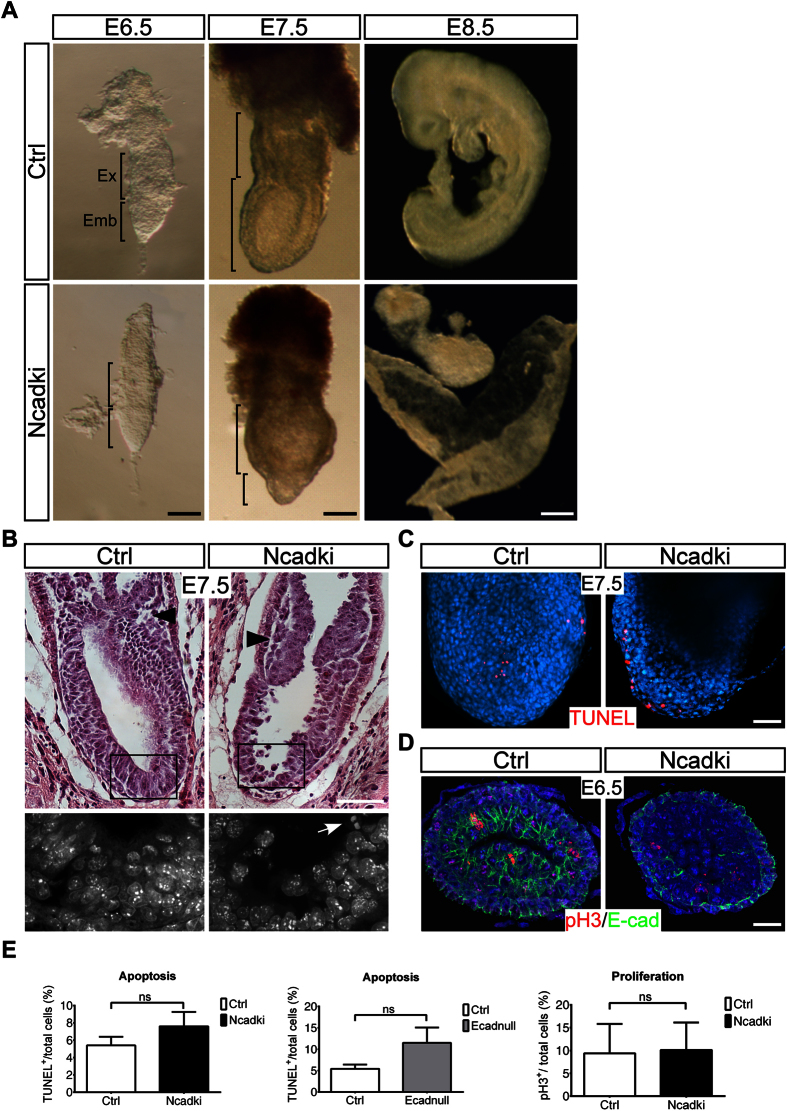
Ectopic switching from E-cad to N-cad expression in the epiblast before gastrulation results in degeneration of the epiblast at E7.5 and embryos are incapable to survive beyond E8.5.(A) Bright field images of EcadNcad/ΔEpi (Ncadki) mutant and EcadNcad/fl and Ecad+/ΔEpi control (Ctrl) embryos at stages between E6.5 and E8.5, showing size reduction of the epiblast in mutant embryos at E7.5. Scale bars represent 100 μm for left and middle and 250 μm for right panel. (B) Histological analysis of sagittal sections at E7.5. In Ncadki embryos the absence of morphological borders between germ-layers are apparent. DAPI staining of the boxed region shows normal distribution of chromatin in detaching cells (lower panel). Arrow indicates condensed chromatin of a pyknotic nucleus. Note, that mutants fail to form and fuse the amnion (arrowhead). Scale bar represents 100 μm (C,D) Analysis of apoptosis at E7.5 by TUNEL (C) and proliferation at E6.5 by pH3 staining (D) with only minor differences between mutant and control embryos. TUNEL-positive (C) and pH3-positive cells (D) are shown in red and E-cad in green (D), nuclei are stained with DAPI. Scale bar represents 50 μm for TUNEL and 20 μm for pH3 staining. Embryos are presented with proximal to the top and anterior to the left (E6.5-E7.5) and anterior to the top and dorsal to the right (E8.5). (E) Quantification of the analysis shown in (C,D), including Ecad−/ΔEpi embryos (Ecadnull); n = 5. Spots were counted using ImageJ multicounting function.